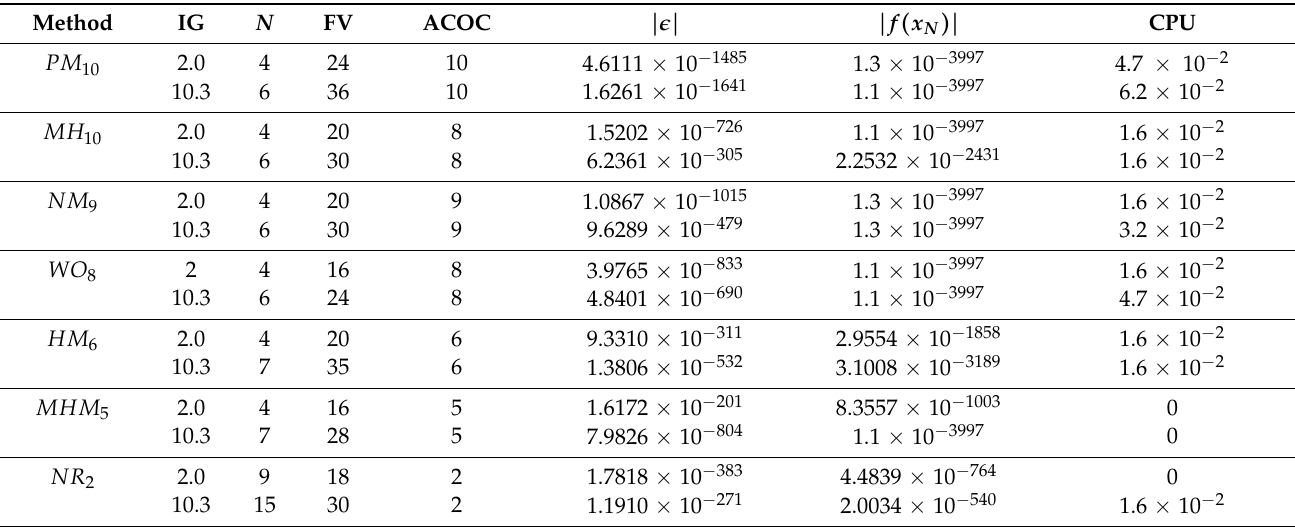
Table 8. Numerical results for problem